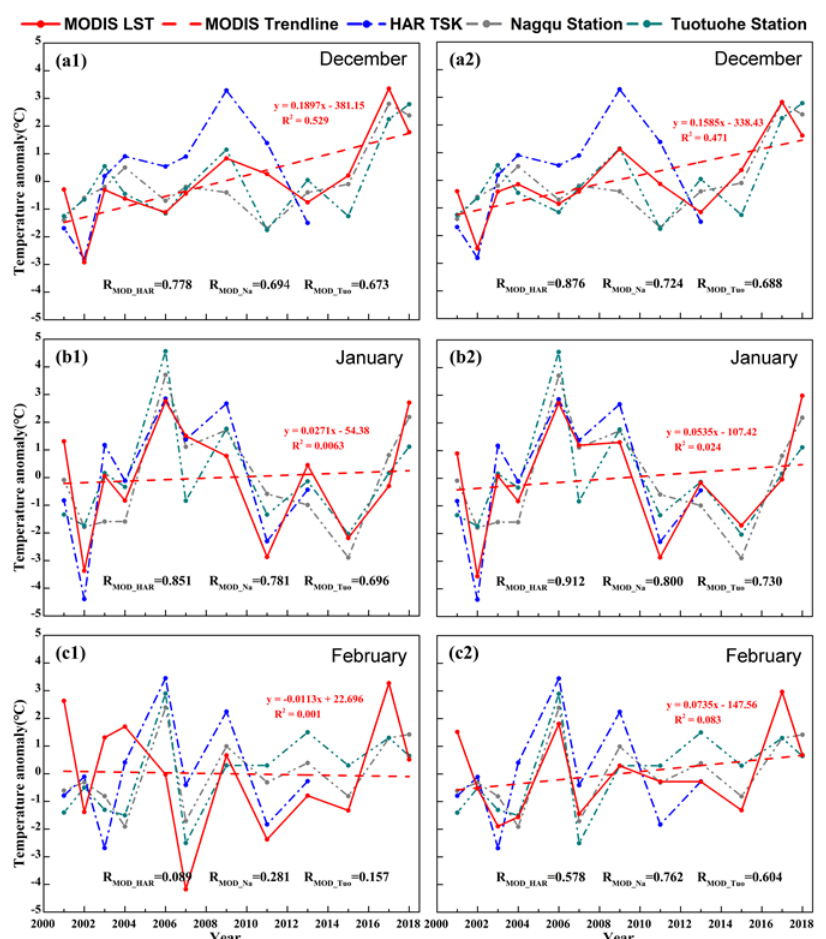
Figure 11. Comparisons of anomalies in regional mean MODIS LST (land surface temperature) and HAR (High Asia refined) data over the Purog Kangri ice field as well as the near-surface temperature from two nearby stations (Nagqu and Tuotuohe) in three winter months. Left column: the regional MODIS LSTs are obtained from all the available data after quality control, ( a1–c1 ) for December, January and February; right column: the regional mean MODIS LSTs are obtained from the available data after quality control and data screening, ( a2–c2 ) for December, January and February.